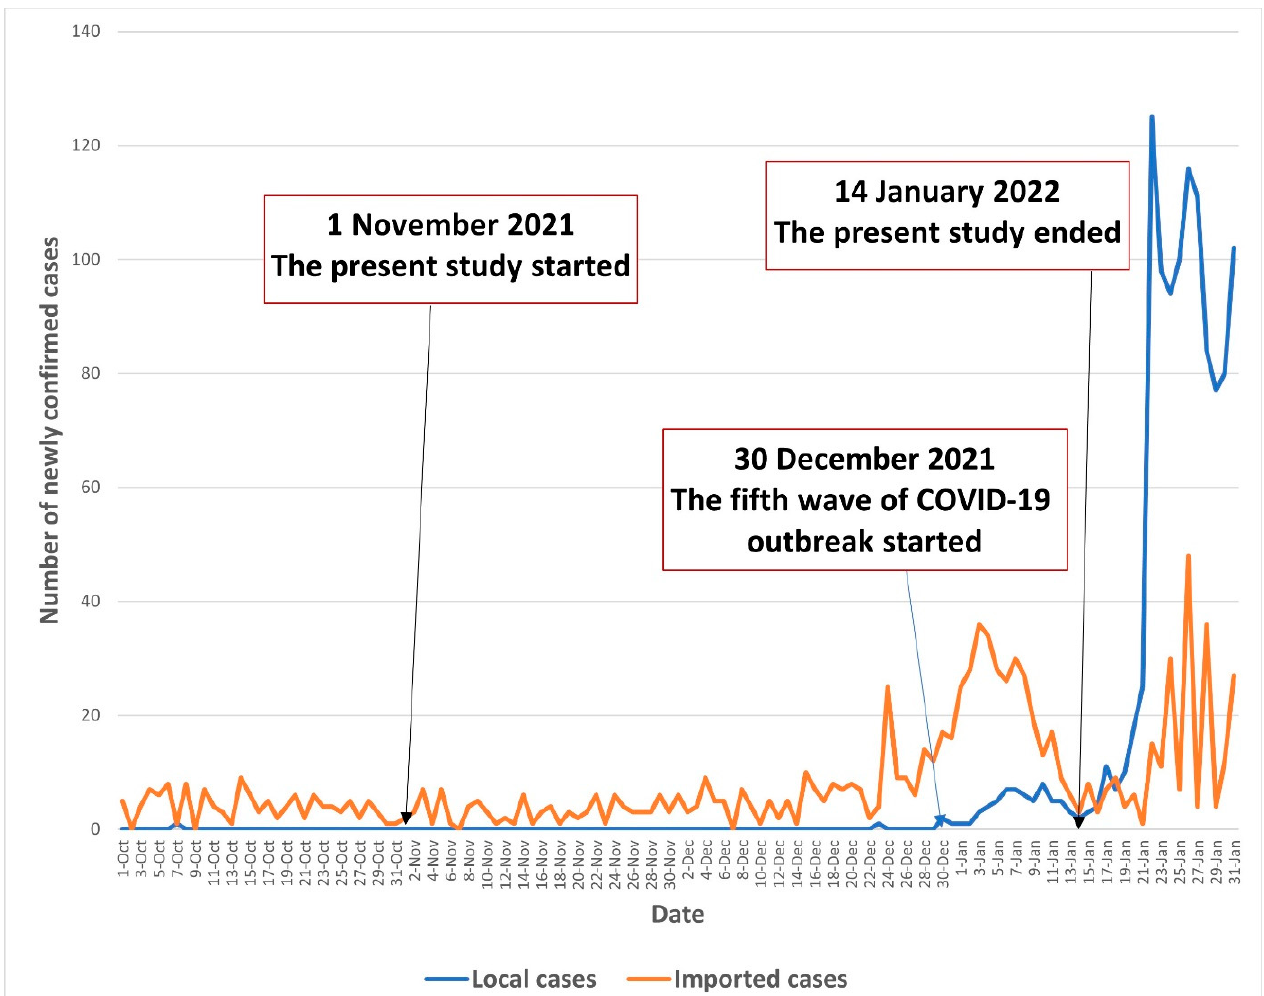
Figure 1. The COVID-19 situation in Hong Kong during the study period.